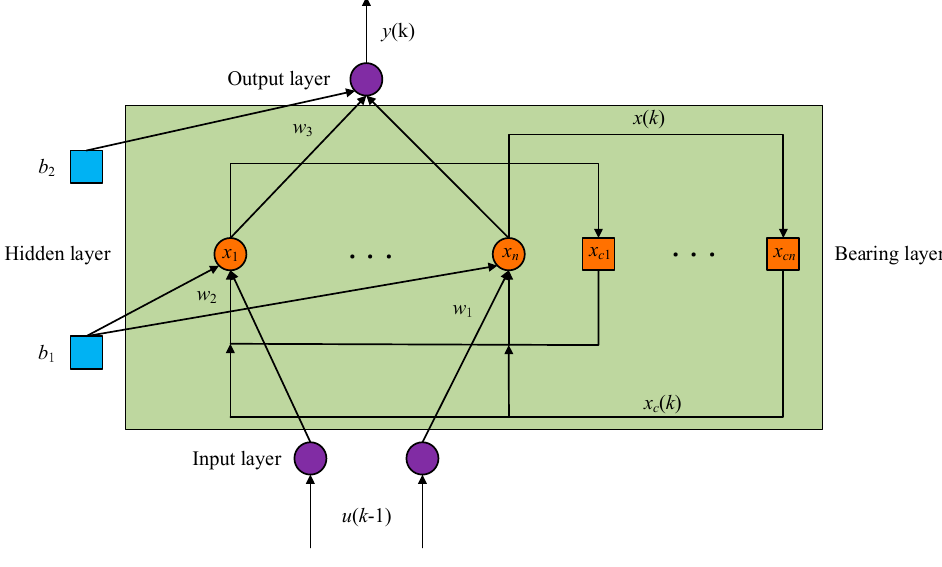
Figure 4. Elman network structure.